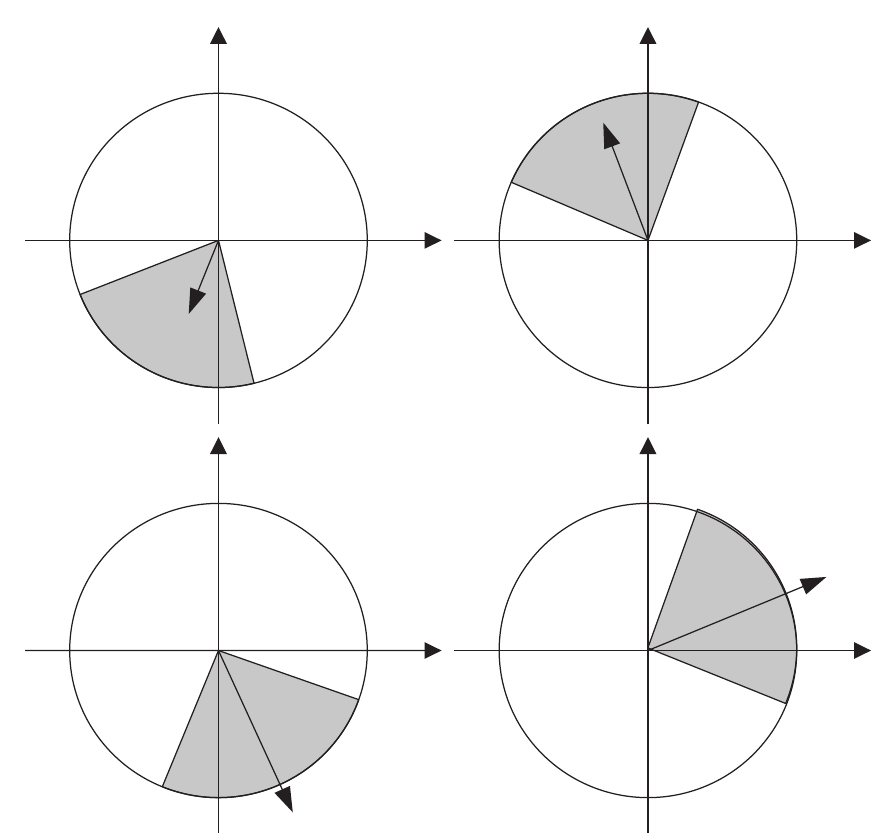
Figure 2: Selection of feature point